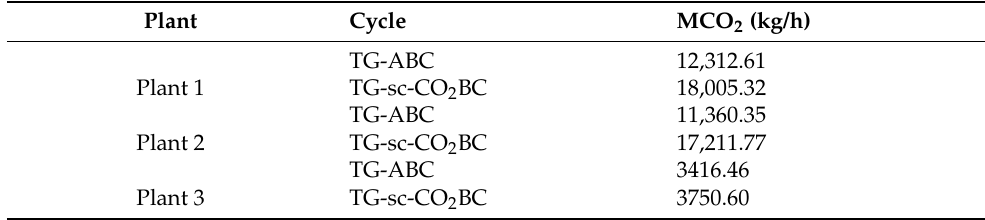
Table 15. CO 2 emission reduction for the different plants.